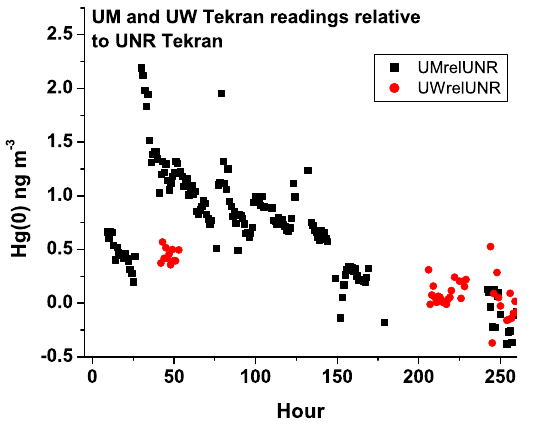
Figure 1. Comparison of Hg(0) readings from the UM, UW and UNR Tekrans over the first 260h of UM measurements. The ab- solute concentration difference relative to the UNR instrument is shown in black for the UM Tekran and in red for the DOHGS (UW) Tekran.